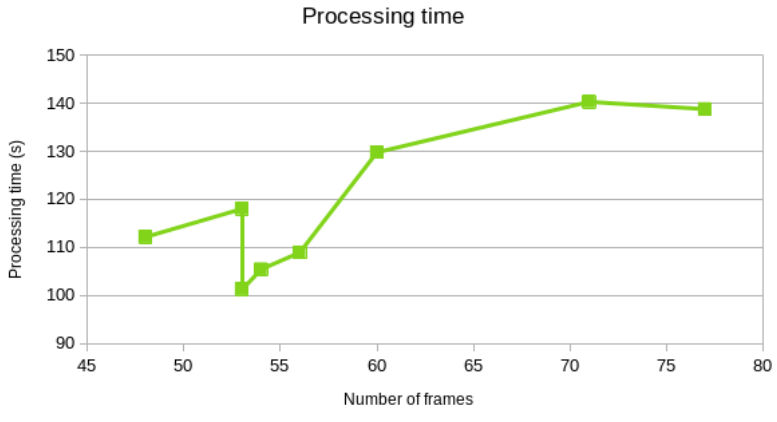
Figure 20. Processing time